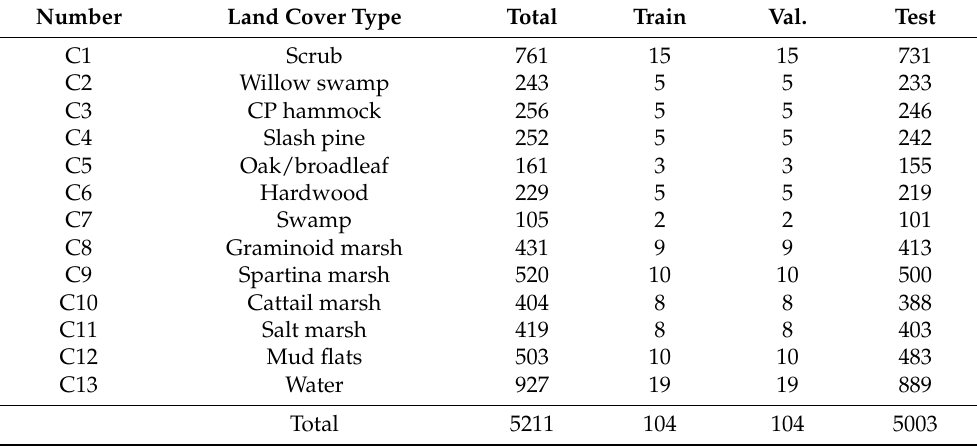
Table 7. The number of total samples, training samples, validation samples, and testing samples for each category of the KSC